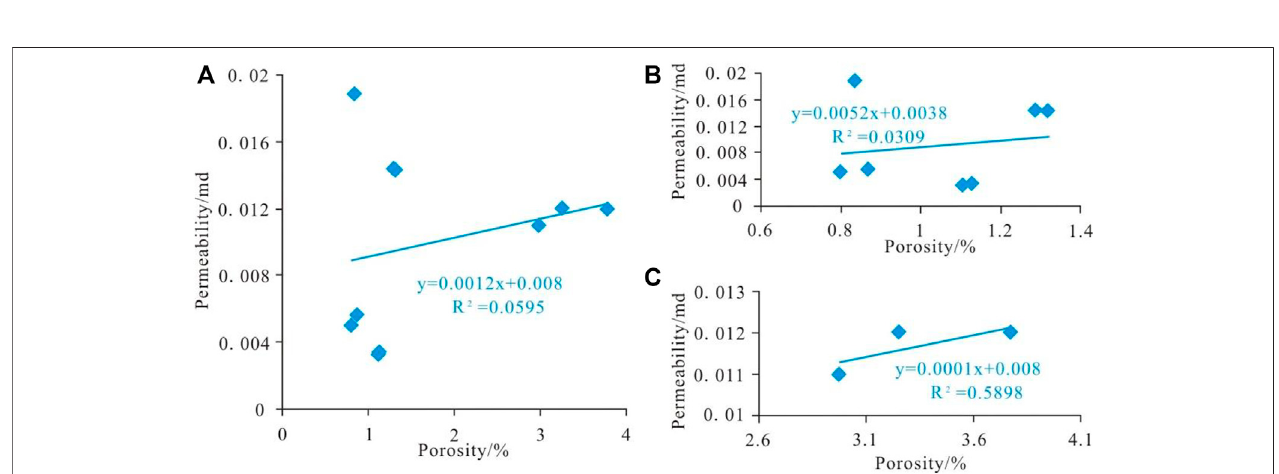
FIGURE9| Therelationshipbetweenpermeabilityandporosity.Therelationshipbetweenpermeabilityandporosityof (A) wellEandwellF, (B) wellFand (C) wellE